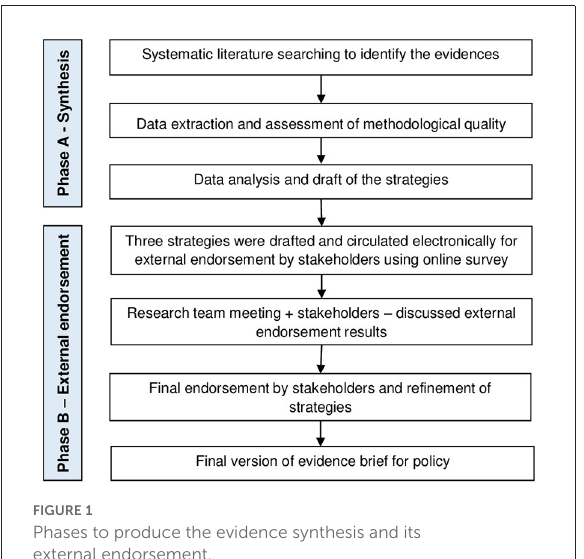
FIGURE1 Phases to produce the evidence synthesis and its external